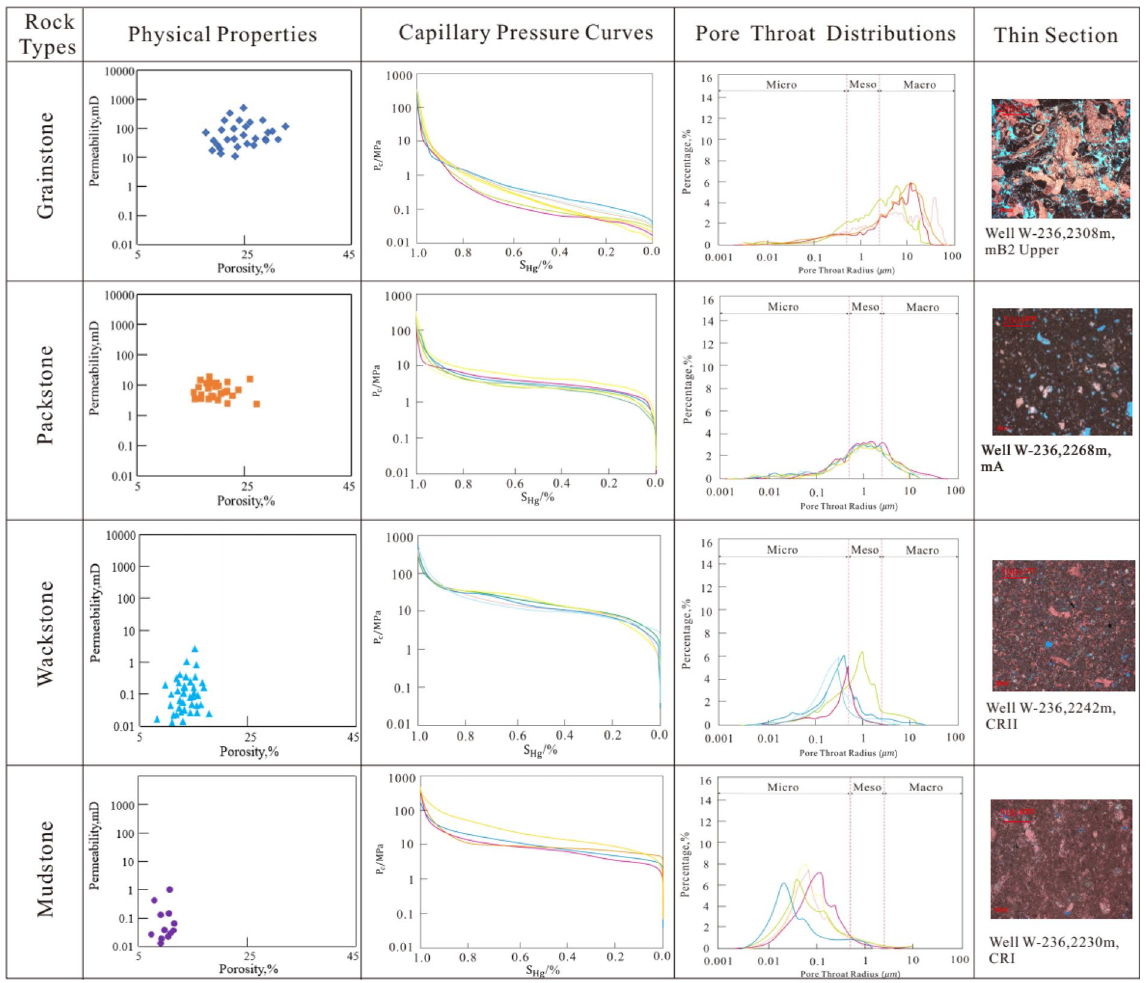
Figure 3. Relationship diagram of pore-throat radius, thin section and pore-permeability of different rock